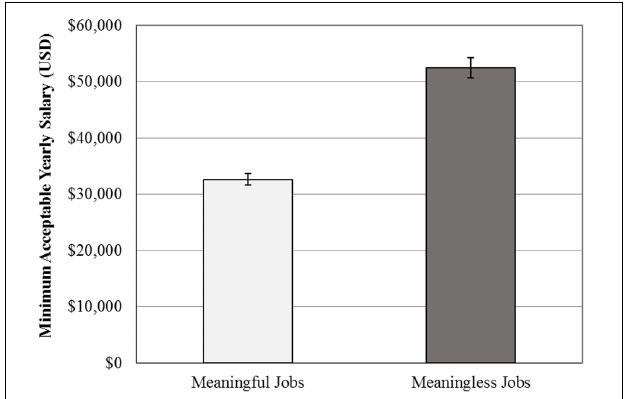
FIGURE 1 | Average minimum acceptable salaries for meaningful and meaningless jobs in Study